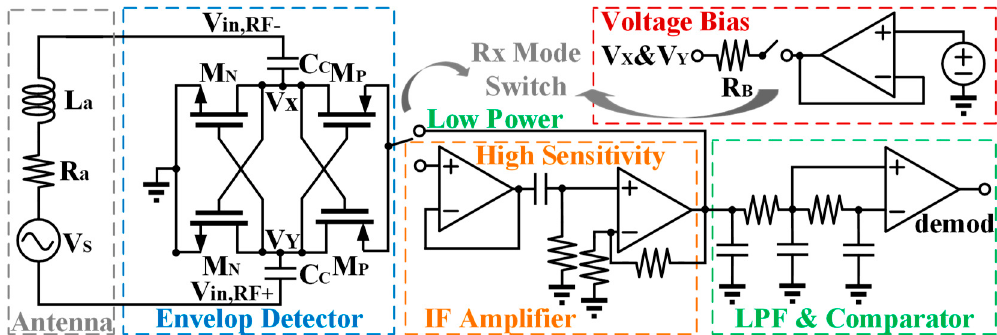
Figure 6. Architecture of proposed dual-mode direct envelope detector based receiver (ED-Rx).